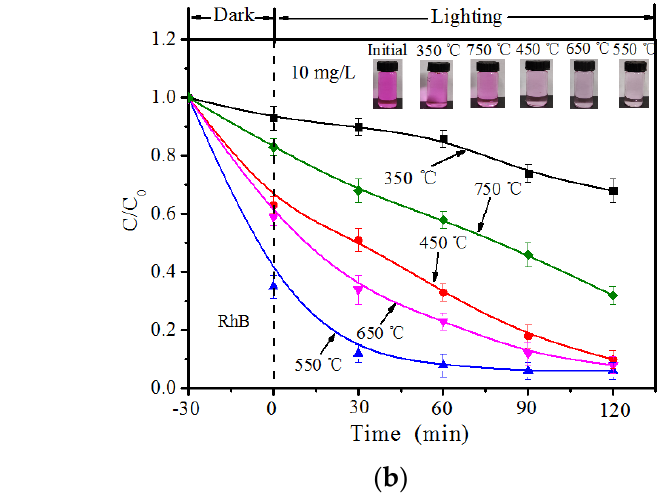
( b ) Figure 4. Cycling experiments of B-TiO 2 /C 3 N 4 for the adsorption – photocatalytic degradation of MB ( a ) and RhB ( b ). Meanwhile, multiple cycle experiments were carried out with MB and RhB. It can be seen from Figure 4 that after four cycles of repeated tests, the adsorption and removal rate of B-TiO 2 /C 3 N 4 to 20 mg/L organic solution decreased from 83.4% to 70.1%(MB) and from 64.1% to 51.2% (RhB). The results showed that the adsorption effect of the material on MB and RhB was weakened gradually. This may have been because the pores on the surface